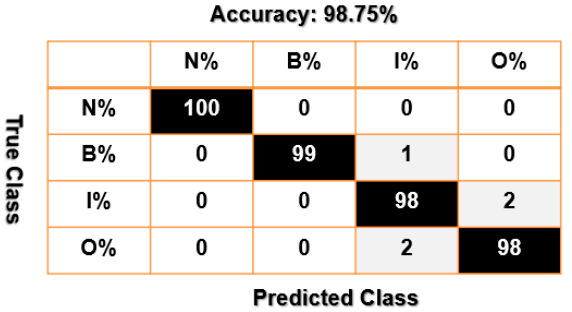
Figure 14. Bearing’s data classification using the combination of the proposed FVSF and SVM.